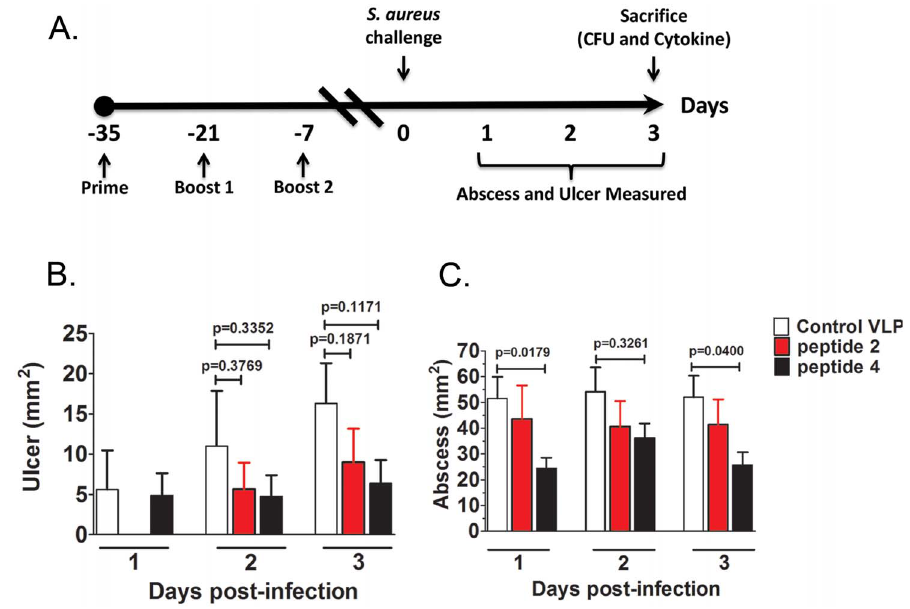
Figure 3. Vaccination with VLP mimotopes of AIP4 is efficacious in a mouse model of S.aureus SSTI. (A) Mice were vaccinated three times at two week intervals with 10 m g of VLP. One week after the final vaccination mice were inoculated subcutaneously with 1 6 10 8 CFU of S. aureus agr -IV isolate AH1872, and abscess (B) and ulcer (C) areas were measured over the course of 72 hours. Data are shown as the mean 6 SEM of at least two independent experments totalling 8–10 mice per